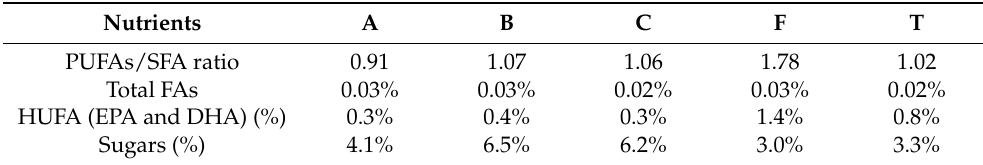
Table 3. Nutritional Profile of Ulva sp. in the human diet (daily dosage: 5 g d.w.) according with the PUFAs/SFA ratio based in the literature [63] and with established Dietary Reference Intake (DRI) based in the literature [2,59,62]. Nutrients A B C F T PUFAs/SFA ratio 0.91 1.07 1.06 1.78 1.02 Total FAs 0.03% 0.03% 0.02% 0.03% 0.02% HUFA (EPA and DHA) (%) 0.3% 0.4% 0.3% 1.4% 0.8% Sugars (%) 4.1% 6.5% 6.2% 3.0%